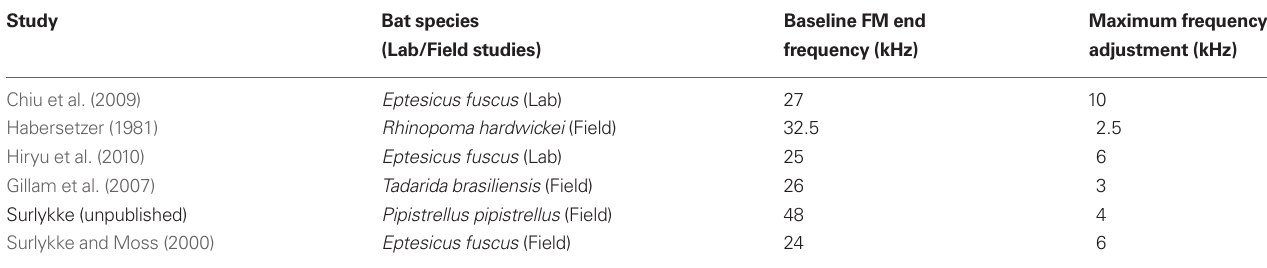
Figure 5 | Call adjustments for frequency streaming in Eptesicus fuscus . Upper left photo illustrating bats vocalizing in close proximity. Photo taken by Jessica Nelson, and image assembled by Chen Chiu. Upper right plots adjustment in call frequency as a function of baseline call separation across bat pairs. Bats with similar baseline calls made larger adjustments in the end